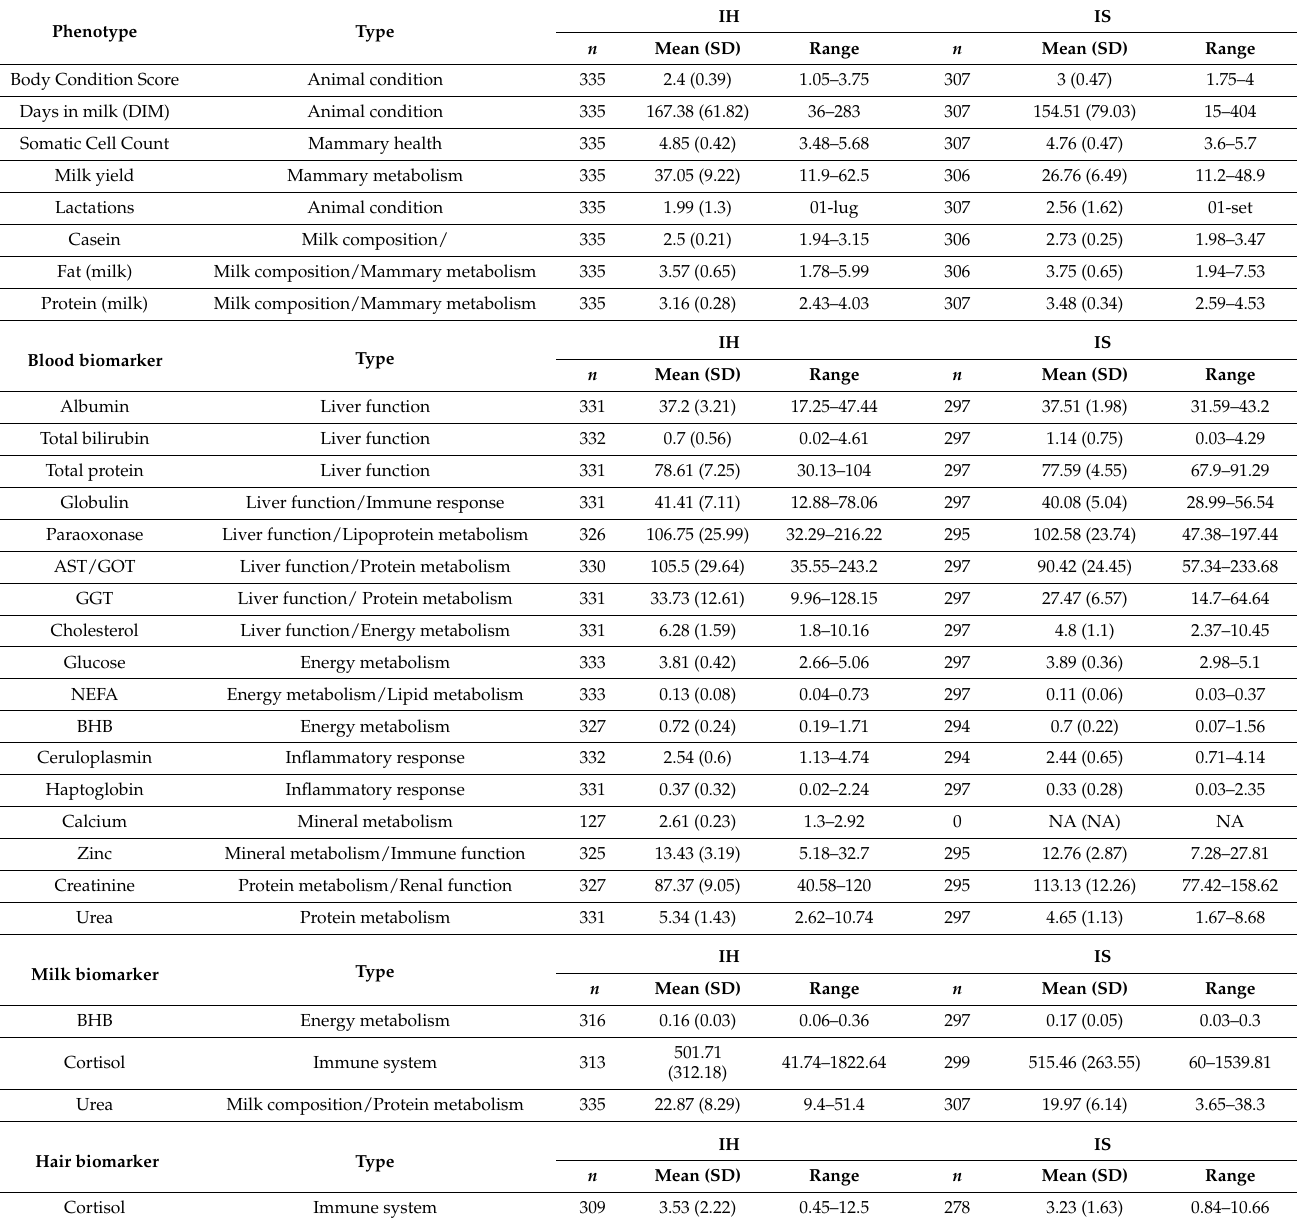
Table 1. Descriptive statistics for